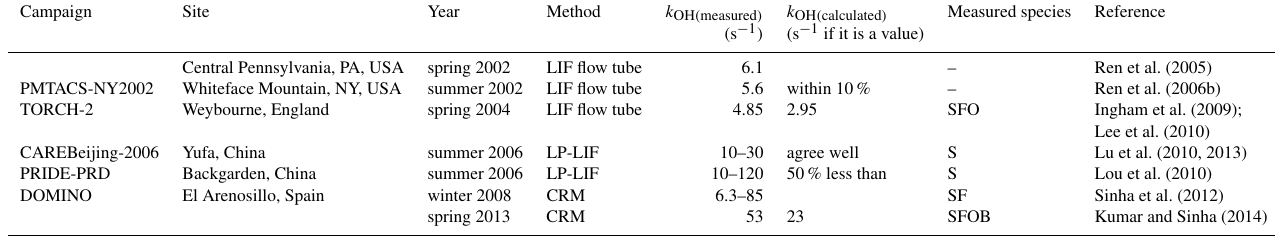
Table 2. Total OH reactivity measurements in suburban and surrounding areas. Campaign